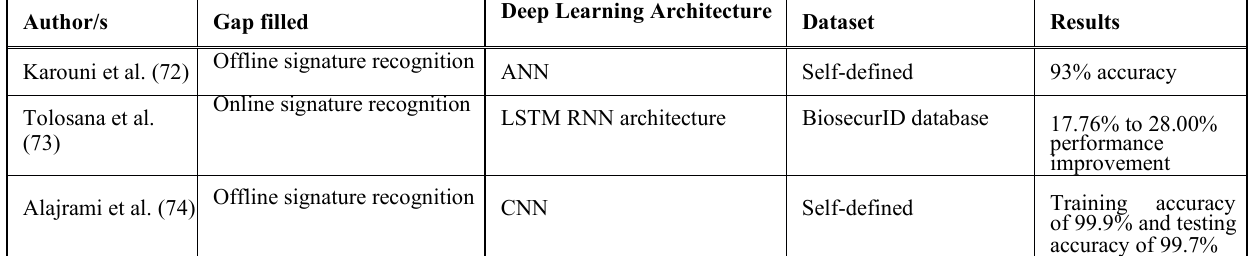
Table 9. Important works on signature based identification using deep